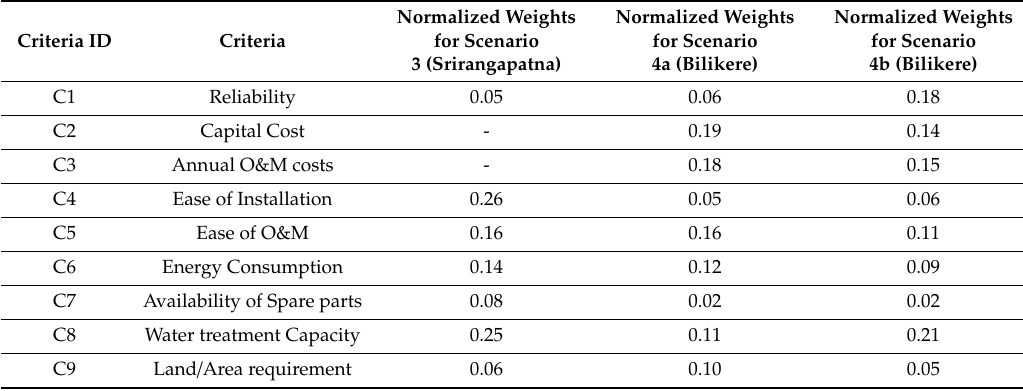
Table 5. Importance weights given to criteria in Scenarios 3 and